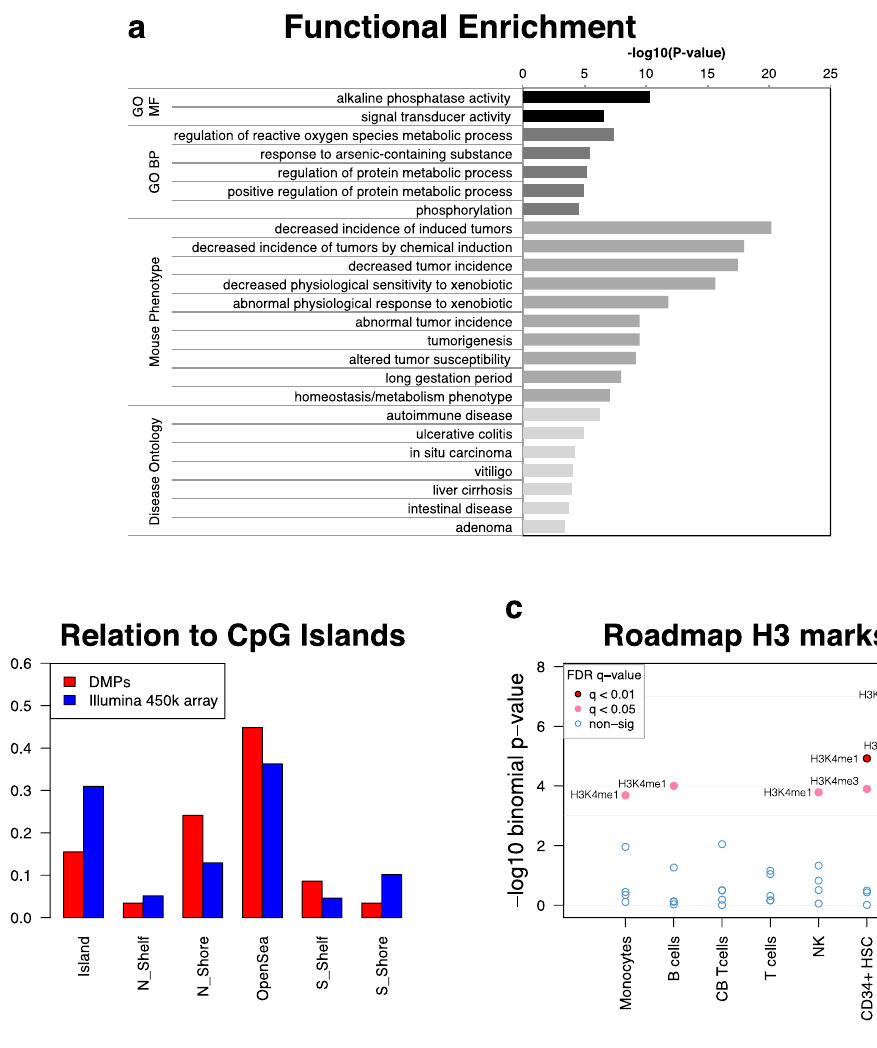
Figure 4. Functional annotation of DMPs. ( a ) GREAT analysis was performed to retrieve functional categories associated with DMPs. Up to top 10 categories per ontology group are shown (FDR < 0.05, fold-enrichment ≥ 2 and at least two gene hits), for the following groups: Gene Ontology Molecular Function (GO-MF), Gene Ontology Biological Process (GO-BP), Mouse phenotype and Disease Ontology. ( b ) For the annotation with respect to CpG islands, the relative fraction of positions located within each feature type is calculated for DMPs (red bars) and the entire 450k array (blue bar). ( c ) The enrichment − log 10 P-values for all H3 histone marks of the blood cell types from NIH Roadmap Epigenomics data was obtained with eFORGE, with default setting. Dots are colored according to the FDR and significant modifications are labeled. Abbreviations: CB, cord blood; HSC, Hematopoietic Stem Cells; S, single